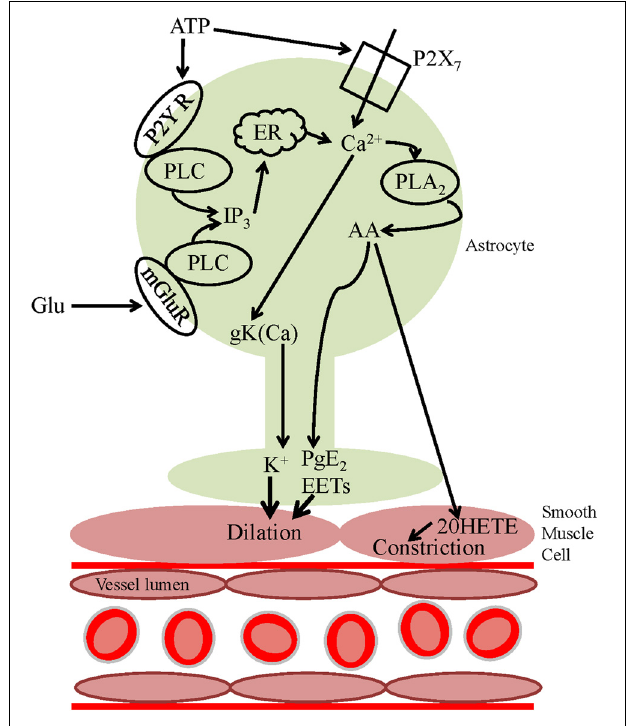
FIGURE 2 | Astrocyte calcium-dependent vasoactive signaling pathways. Neuronally released glutamate can act on astrocyte mGluRs, activating PLC, and increasing astrocyte [Ca 2 + ] i , activating PLA2 resulting in the release of AA from the plasma membrane. AA can be metabolized within the astrocyte to form PgE 2 or EETs which are released and act on smooth muscle cells, evoking vasodilation. Alternatively, AA can be released and act on smooth muscle cells where it is metabolized to the vasoconstrictor 20-HETE. ATP can activate Ca 2 + -mediated downstream vasoactive pathways either by acting on P2Y receptors and activating PLC or via P2X 7 receptors, increasing [Ca 2 + ] i . An alternative vasoactive pathway downstream of the [Ca 2 + ] i increase is the activation of BK Ca channels and subsequent efflux of the vasodilator K +